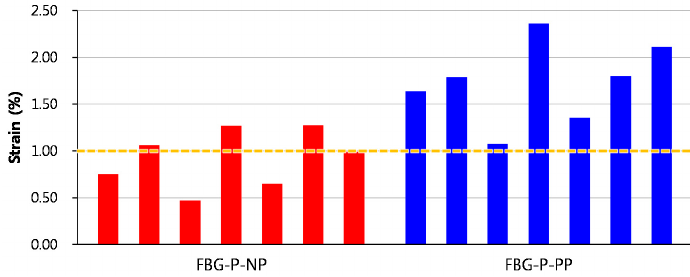
Figure 14. Maximum strain measurement ranges of the FBG sensors.